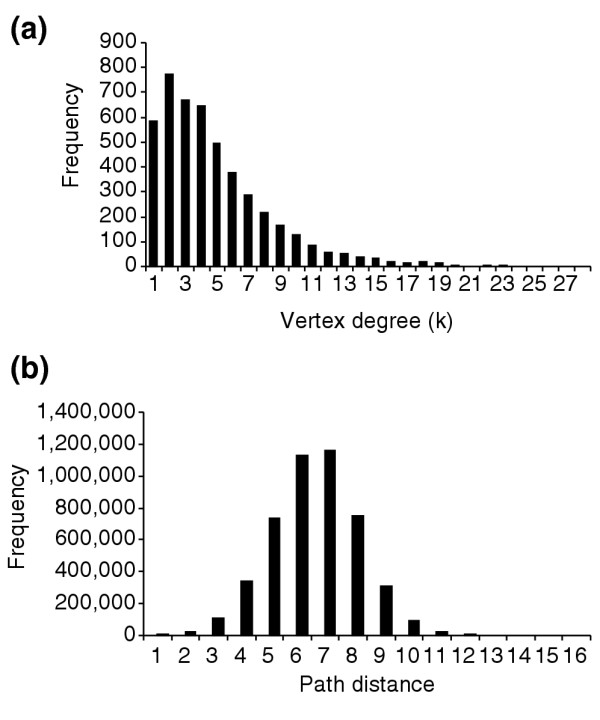
Topological properties of the yeast FOCI coexpression network. Distribution of (a) vertex degrees and (b) path lengths for the network.